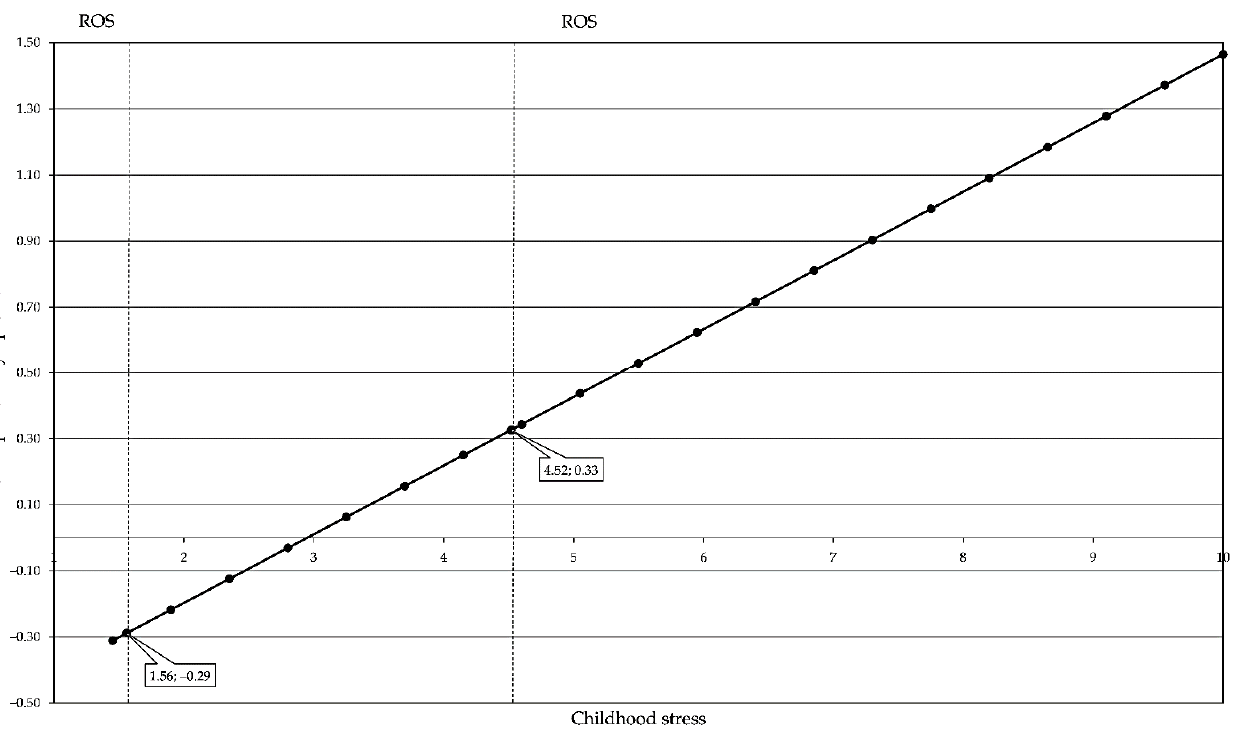
Figure 5. Region of significance (RoS) for the conditional effect of BDNF rs6265 on depressive symptoms in wave 2 at different levels of childhood stress.